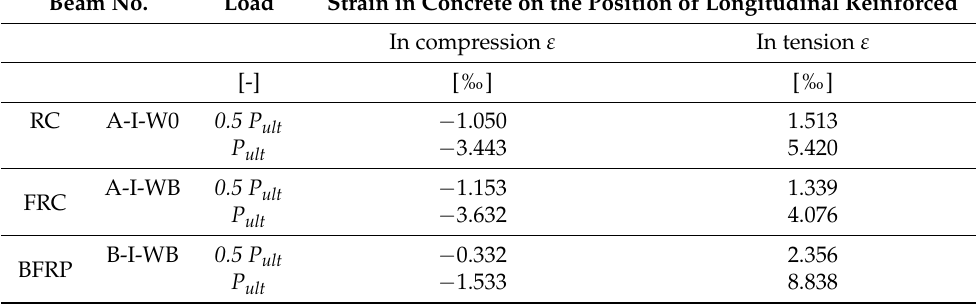
Table 5. Strain in concrete.